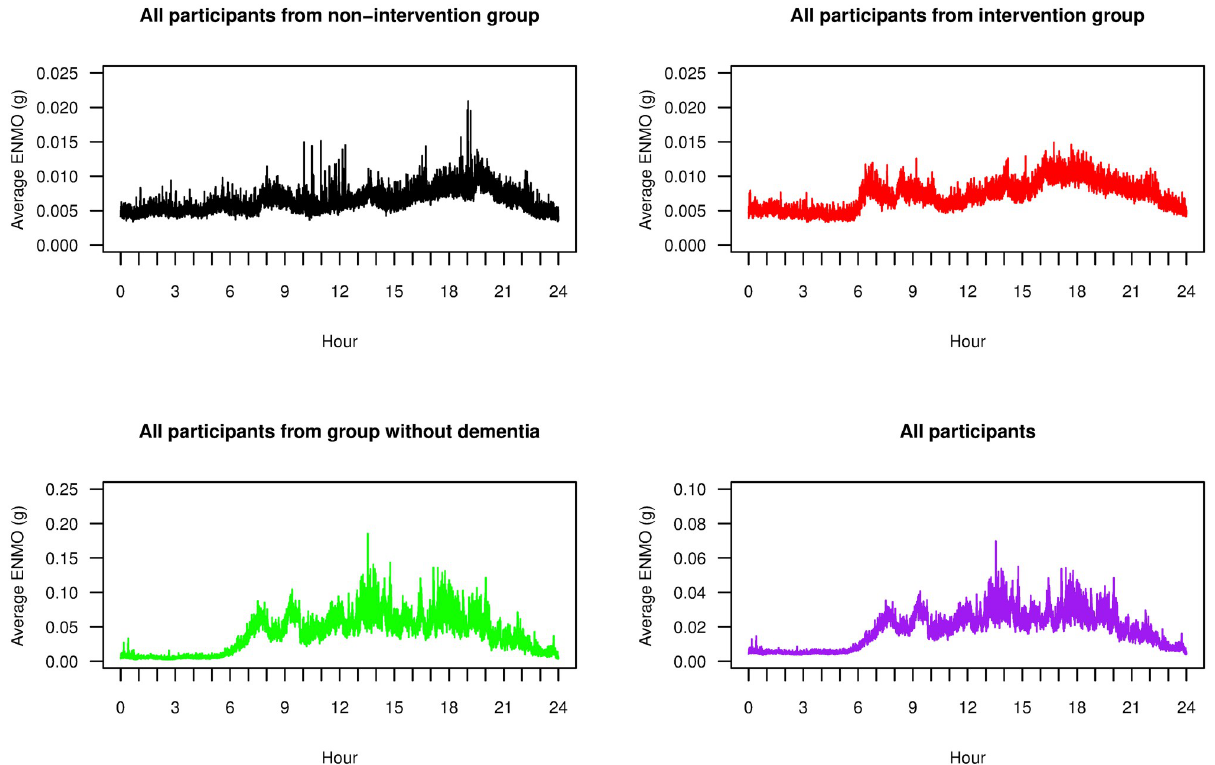
Fig 7. Average ENMO over participants. Time series plots of 24-hour ENMO values averaging over all participants in each of the non-intervention group (black), the intervention group (red), the group of individuals without dementia (green), and all groups together (purple).